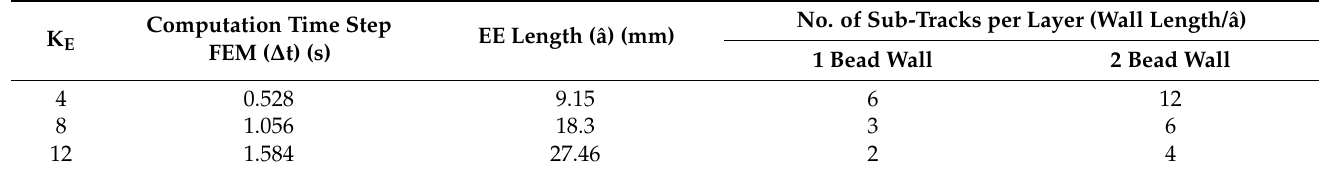
Table 5. Elongated ellipsoid (EE) heat source model parameters used in the present